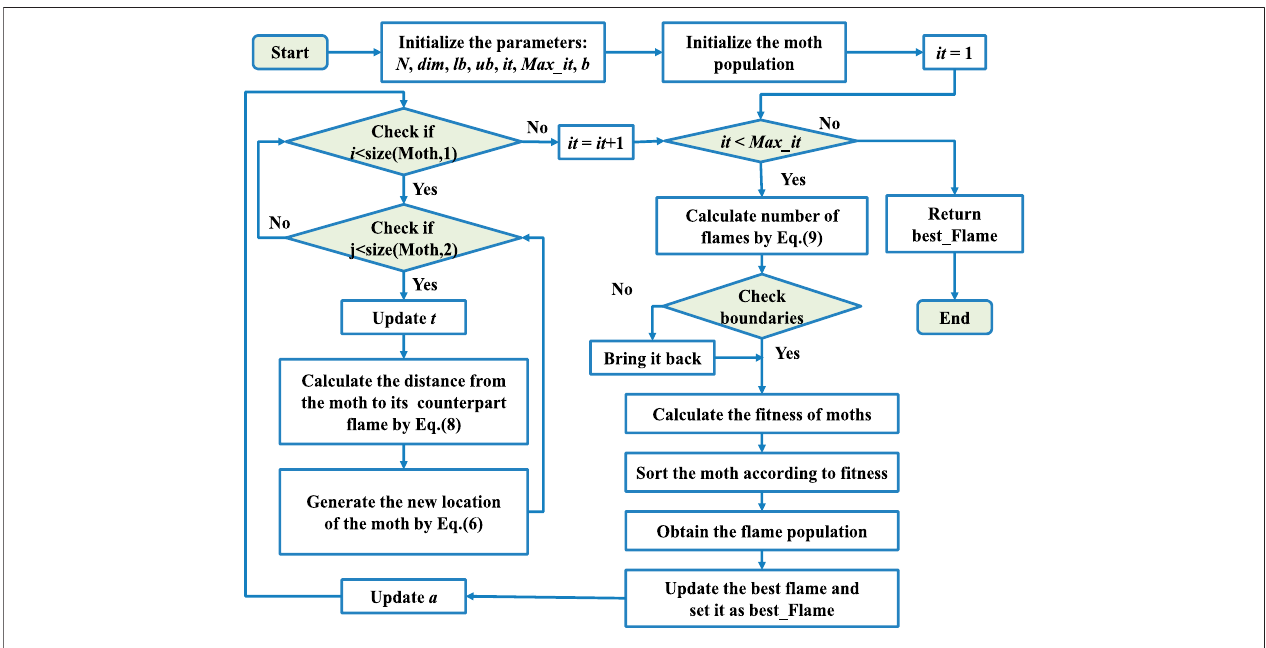
FIGURE 1 | Flowchart of